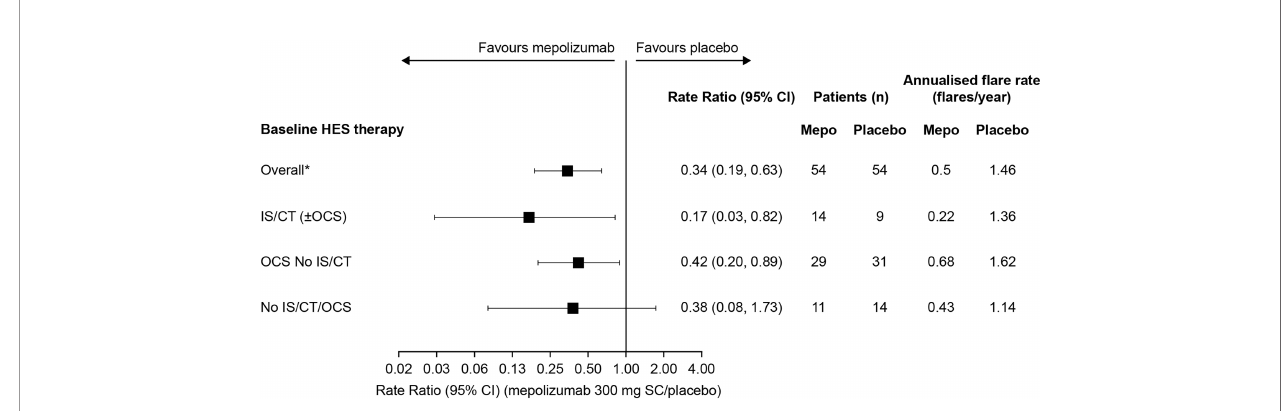
FIGURE 2 | Annualised rate of fl ares with mepolizumab versus placebo by baseline treatment type. *These values were originally reported in Roufosse et al., 2020. CI, con fi dence interval; CT, cytotoxic therapy; HES, hypereosinophilic syndrome; IS, immunosuppressive therapy; OCS, oral corticosteroid; SC,